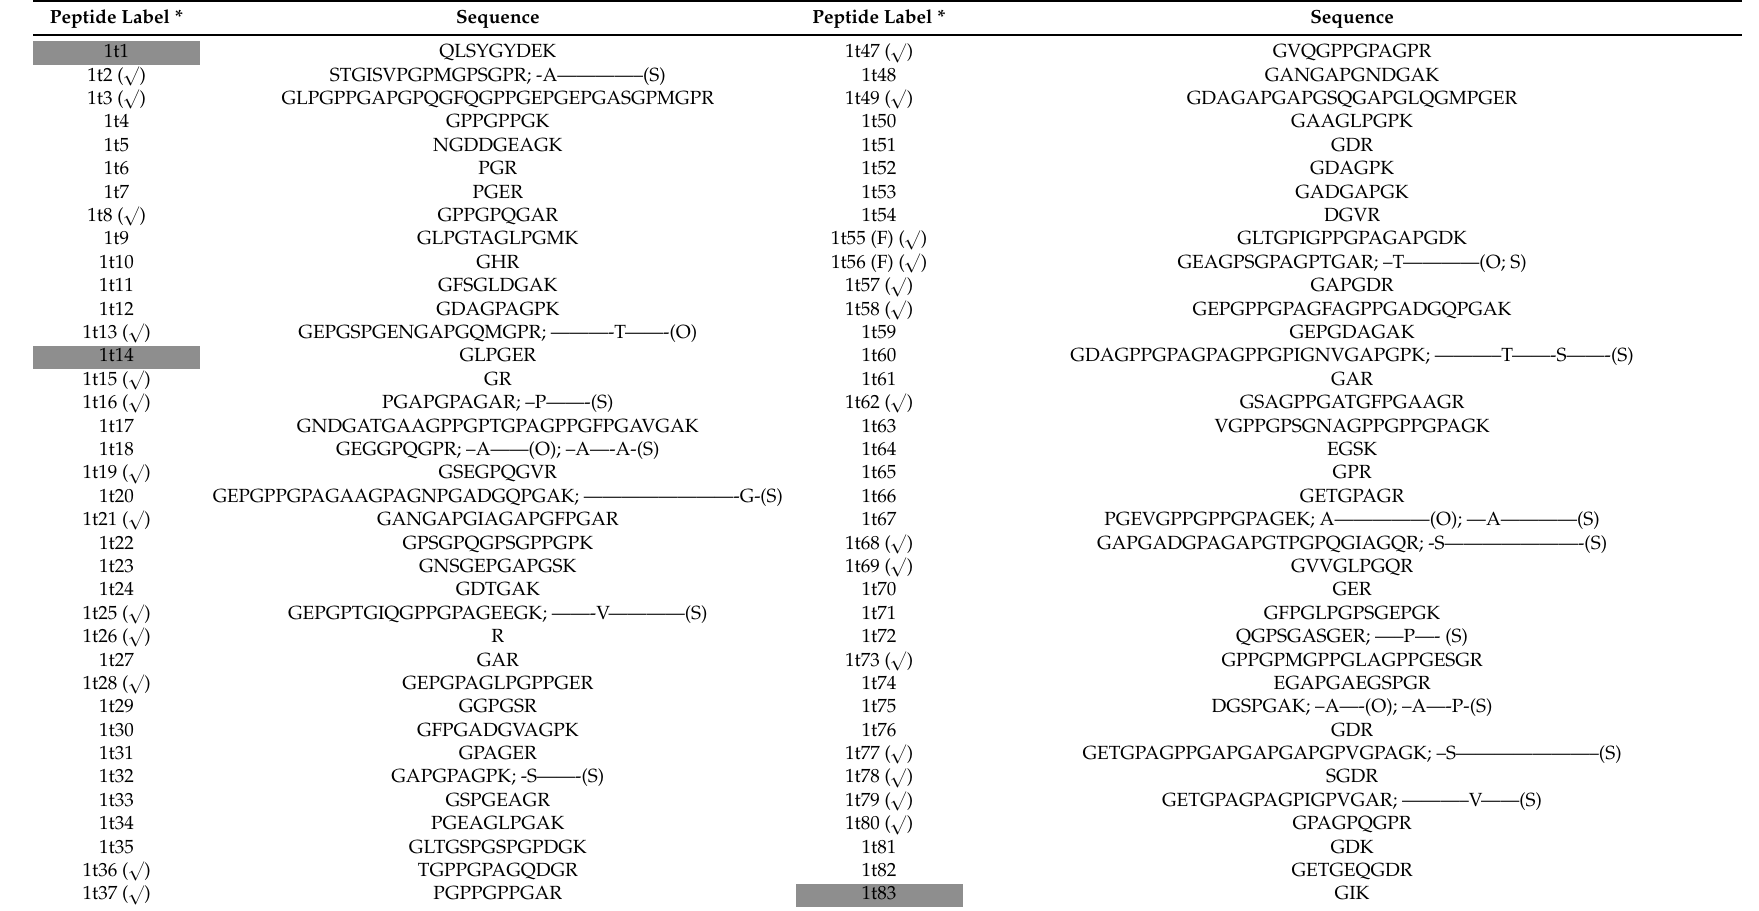
Table 1. Collagen alpha 1(I) (COL1A1) peptide sequences showing amino acid variations between artiodactyl taxa (hyphen indicates identical amino acid residue ‘ as the main sequence = Bos ; sequences followed by O = Ovis and S = Sus ). ( ) indicates observation of precursor in (at least 2 of 3) fingerprints (peptide mass fingerprinting (PMF) data); shaded cells indicate lack of observation in (at least 2 of 3) liquid chromatography (LC)-based results (see Tables S1–S3); single lettering under “Peptide label” indicates PMF species biomarker from Buckley et al.